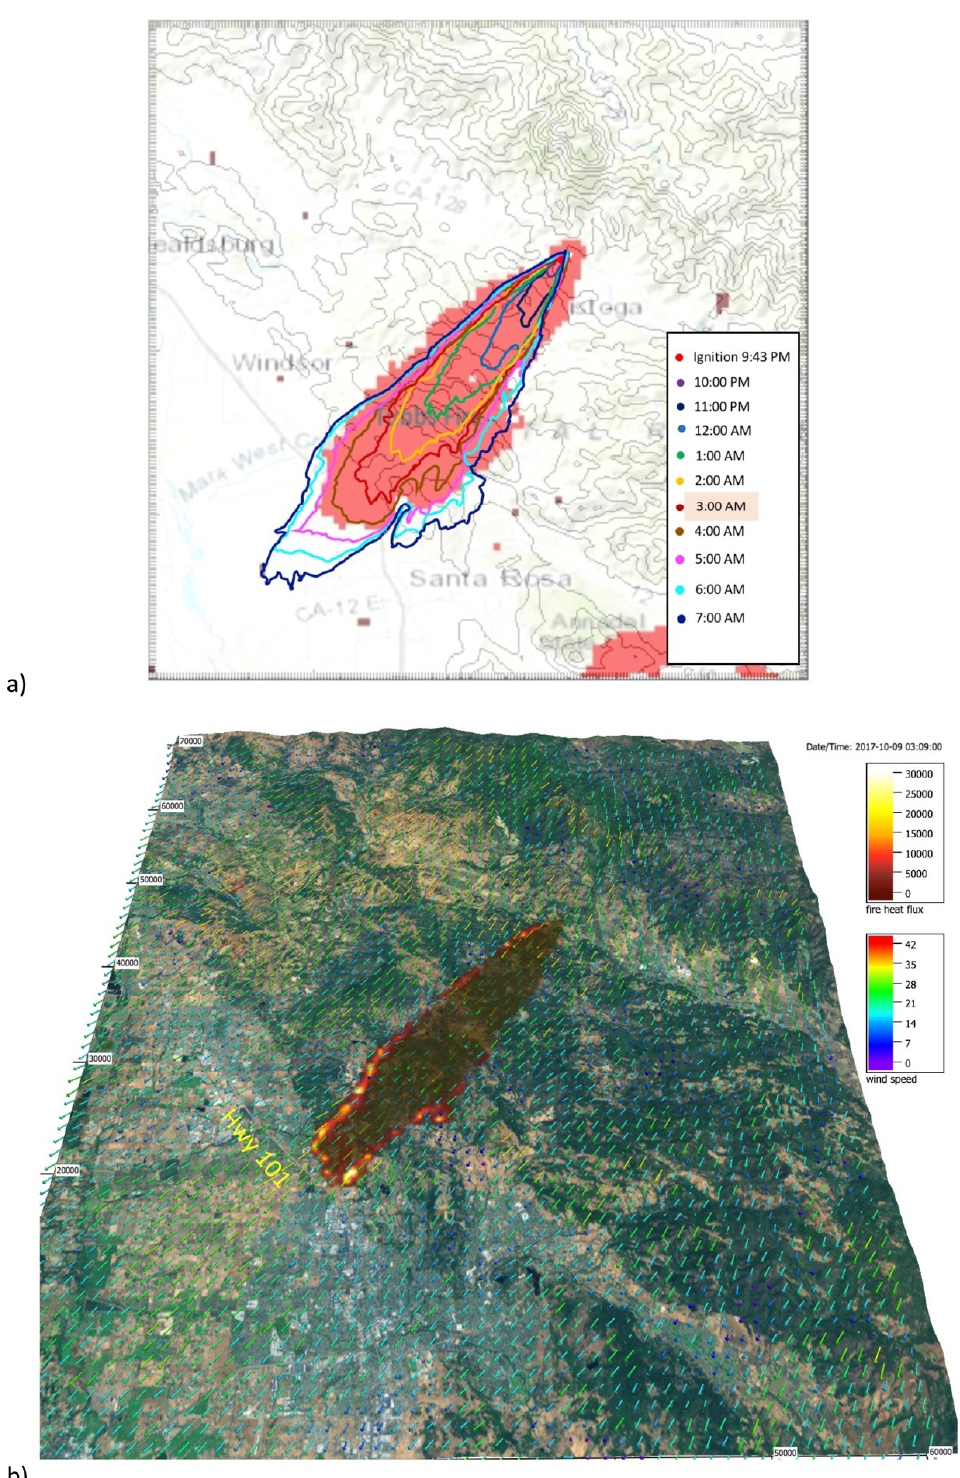
Figure 10. Retrospective research simulation of the Tubbs Fire using CAWFE. ( a ) VIIRS active fire detection data of the Tubbs Fire at 3:09 a.m. underlies simulated fire perimeter, the times of which are given by the legend. The red contour line corresponds to the time of the VIIRS observation. Terrain contour intervals are shown every 100 m; ( b ) The fire’s heat flux is show in the upper color bar (in W/m 2 ). Wind speed arrows (in m/s) point downstream and are colored according to the color bar at right. Vectors are shown every three grid points.